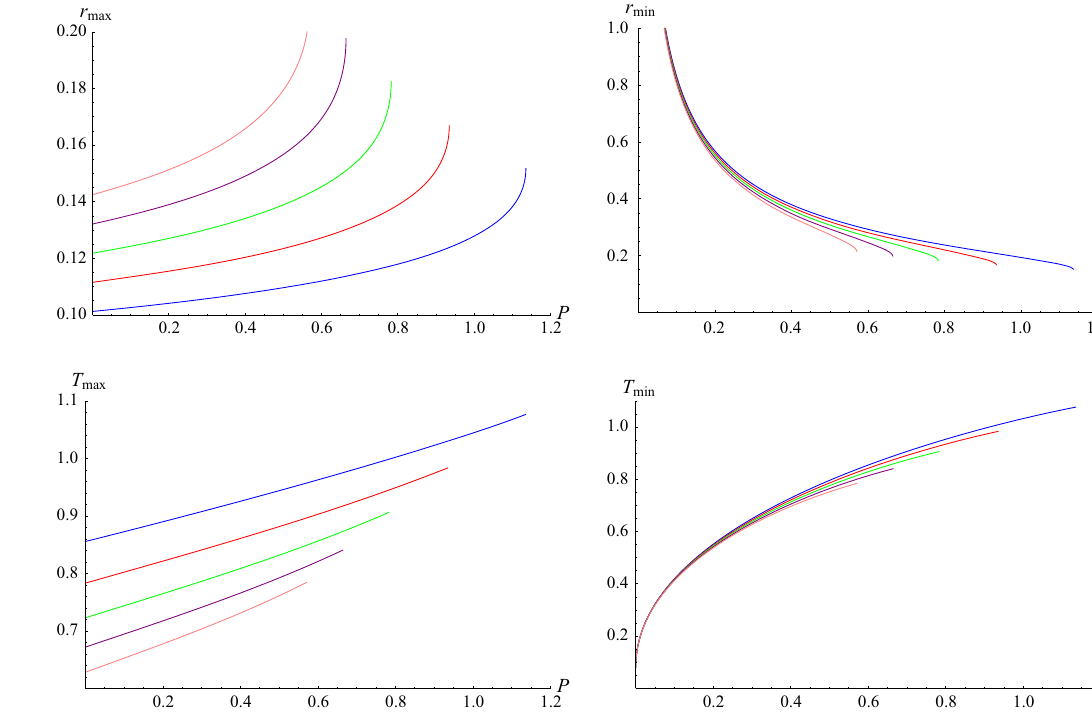
parameter k of the non-linear electrodynamics, at m = c = c 1 = c 2 = 1. The blue, red, green, purple and pink curves correspond to k = 0 . 1, 0 . 11, 0 . 12, 0 . 13, 0 . 14,